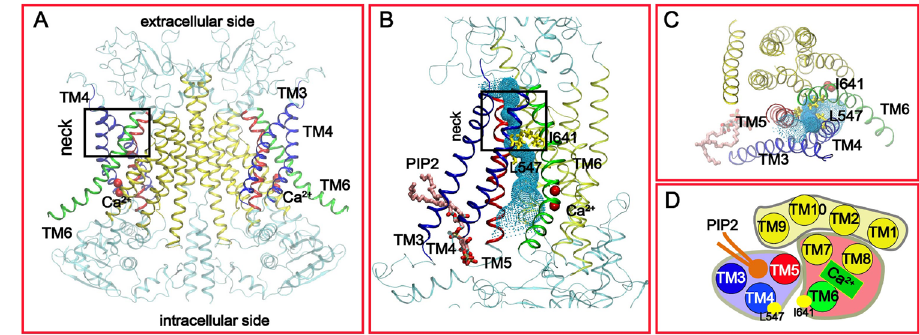
Fig. 1 Structural features of the Ca 2 + -bound mTMEM16A channel. A The overall dimer structure with key TM helices highlighted (PDB: 5oyb). B , C Front and top views of the putative conducting pore. The pore pro fi le calculated using HOLE 39 is illustrated using the green dots. The two key hydrophobic residues, L547 and I641, in the “ neck ” region are shown in yellow sticks. The pore-lining TMs are colored in blue (3 and 4), red (5) and green (6), respectively. The other TMs are colored in yellow. The bound PIP 2 molecule is represented as sticks in panels B and C . D Cartoon representation of the functional domain organization of TMs from the top. The pore-forming domain consists of the PIP 2 -binding regulatory module (TMs 3-5) and Ca 2 + -binding activation module (TMs 6 – 8). TMs 1, 2, 9, and 10 form the dimerization and supporting